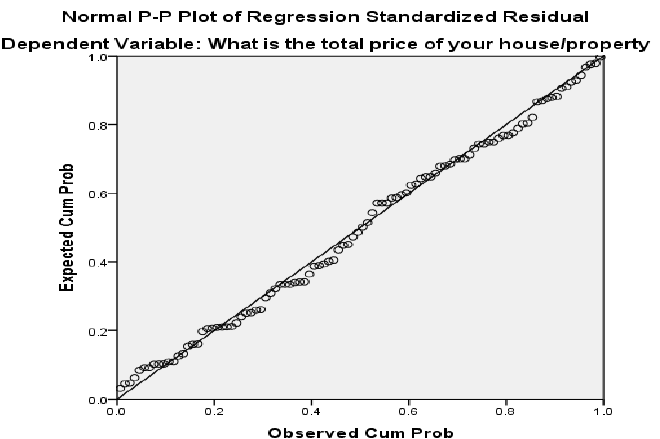
Figure 4. Scatter plot showing the regression line graph for applied